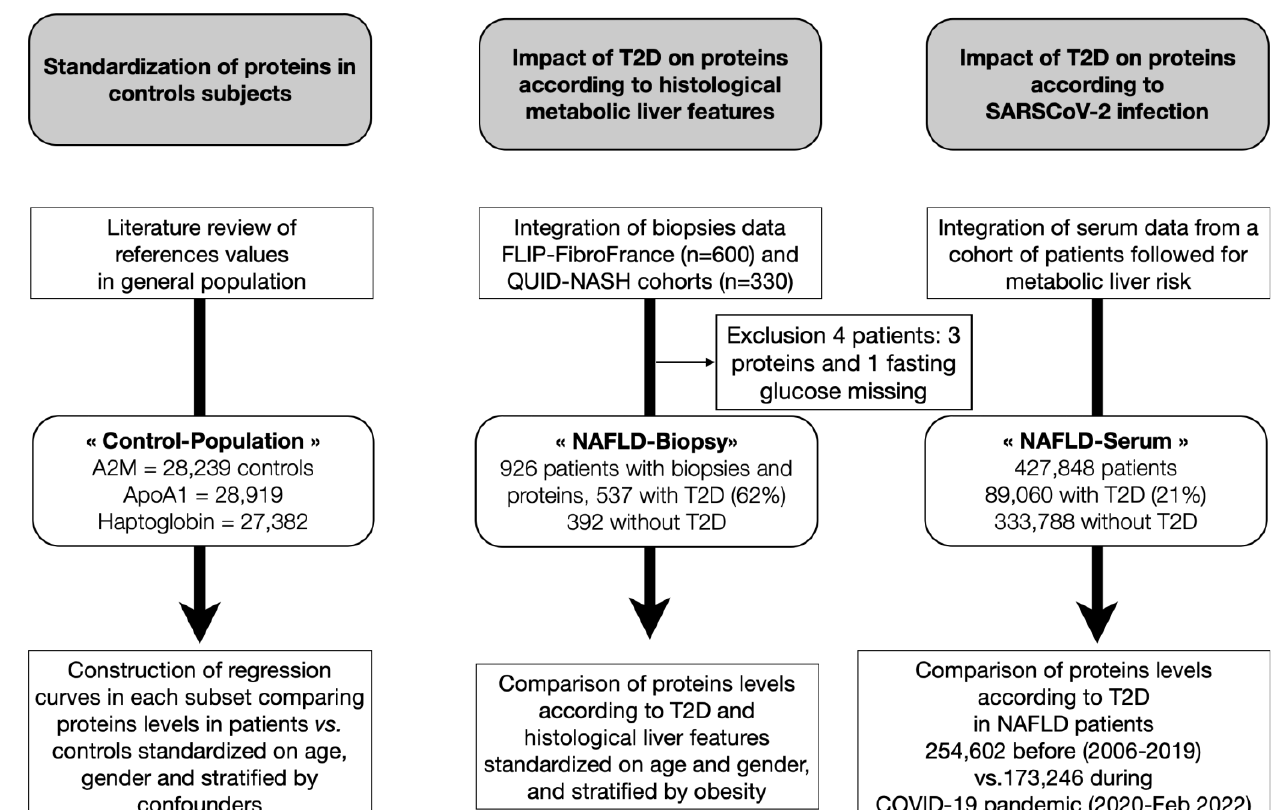
Figure 1. Study design.